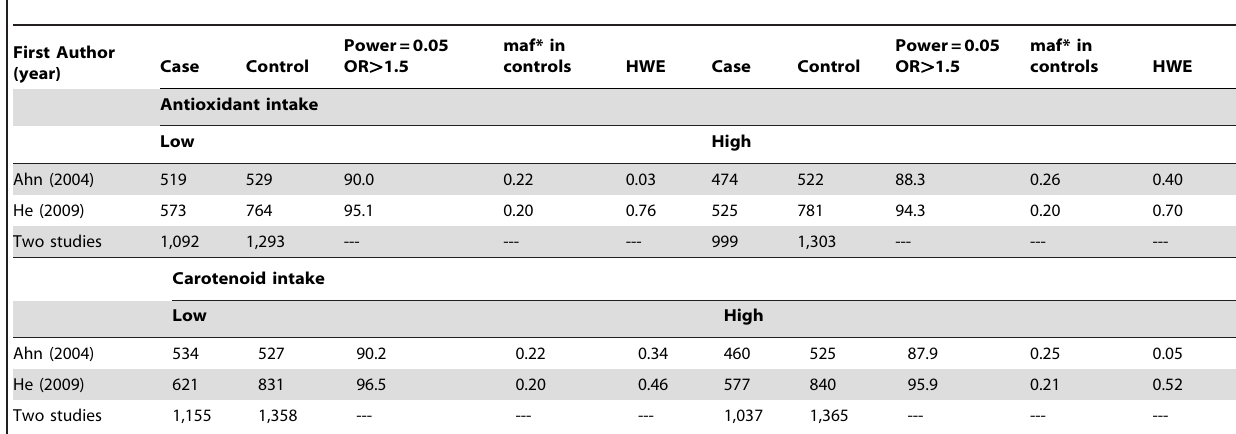
Table 2. Characteristics of the studies of MPO-G463A polymorphism and its association with breast cancer stratified by antioxidant and vitamin-carotenoid